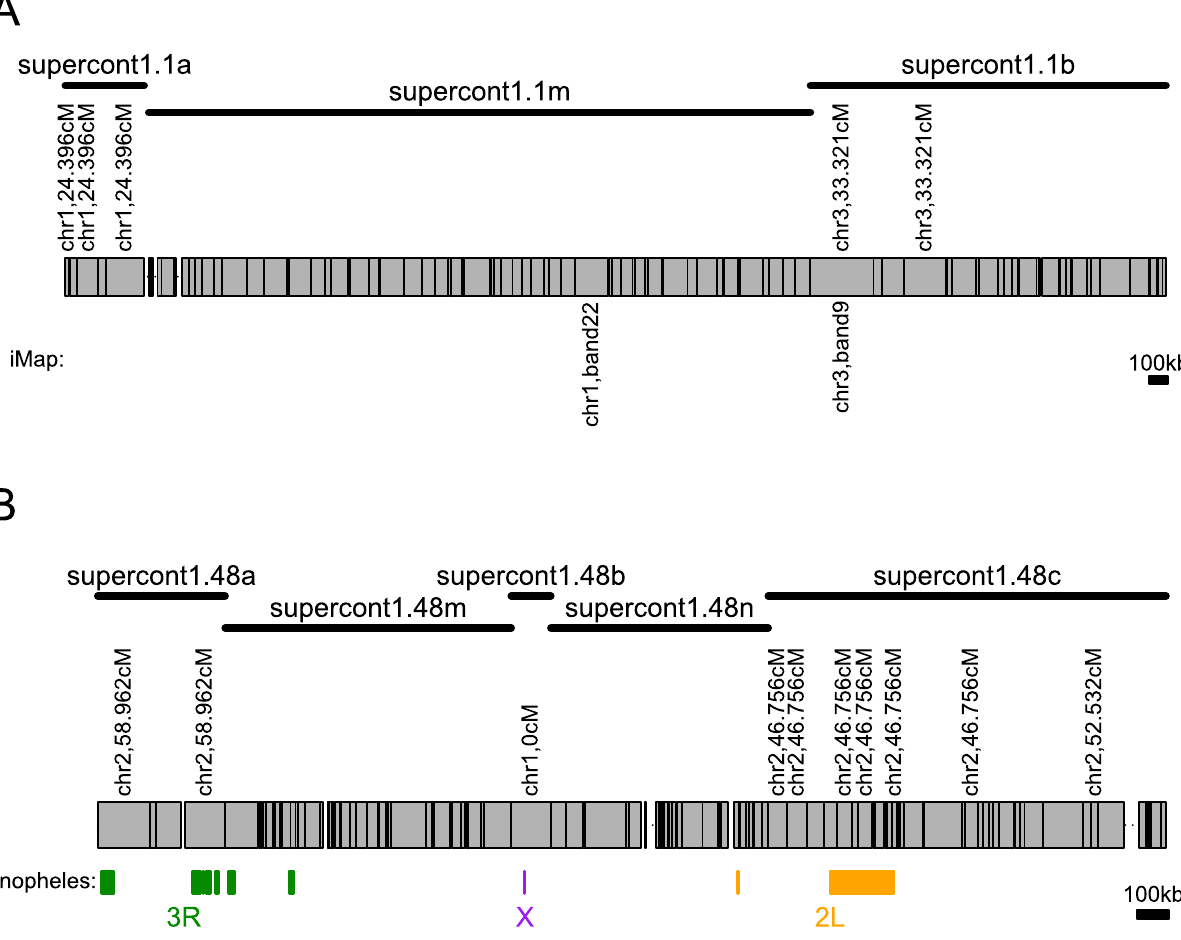
Synteny Synteny has previously been observed between whole chromo-